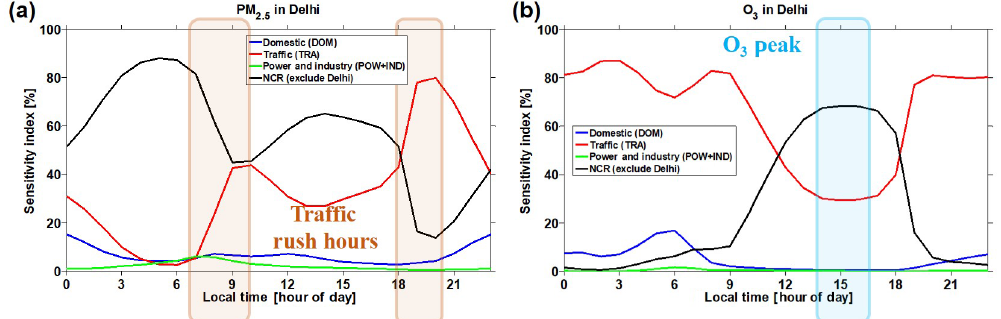
Figure 5. Averaged diurnal pattern of global sensitivity indices during the 2–15 May simulation period. (a) PM 2 . 5 ; (b) O 3 . The PM 2 . 5 and O 3 results are averaged over Delhi city region (marked with red box in Fig. 2). The morning and evening rush hours and the period of peak ozone are marked with the boxes to highlight the notable changes in contribution from each emission sector.